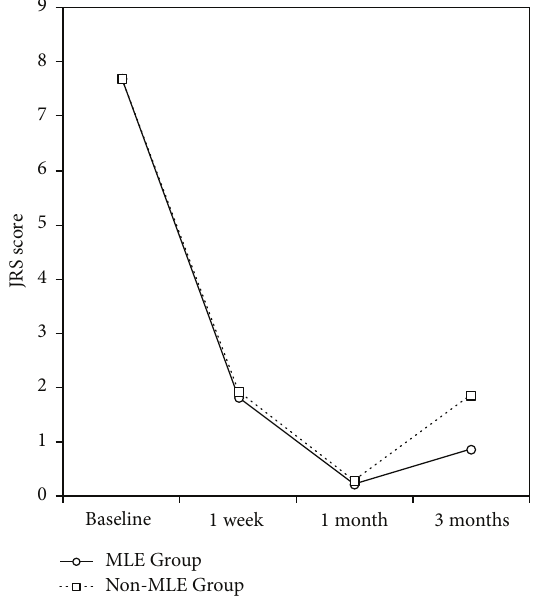
Figure 3: Changes in JRS scoreof the MLEGroup and the non-MLE Group before and after BoNT-A